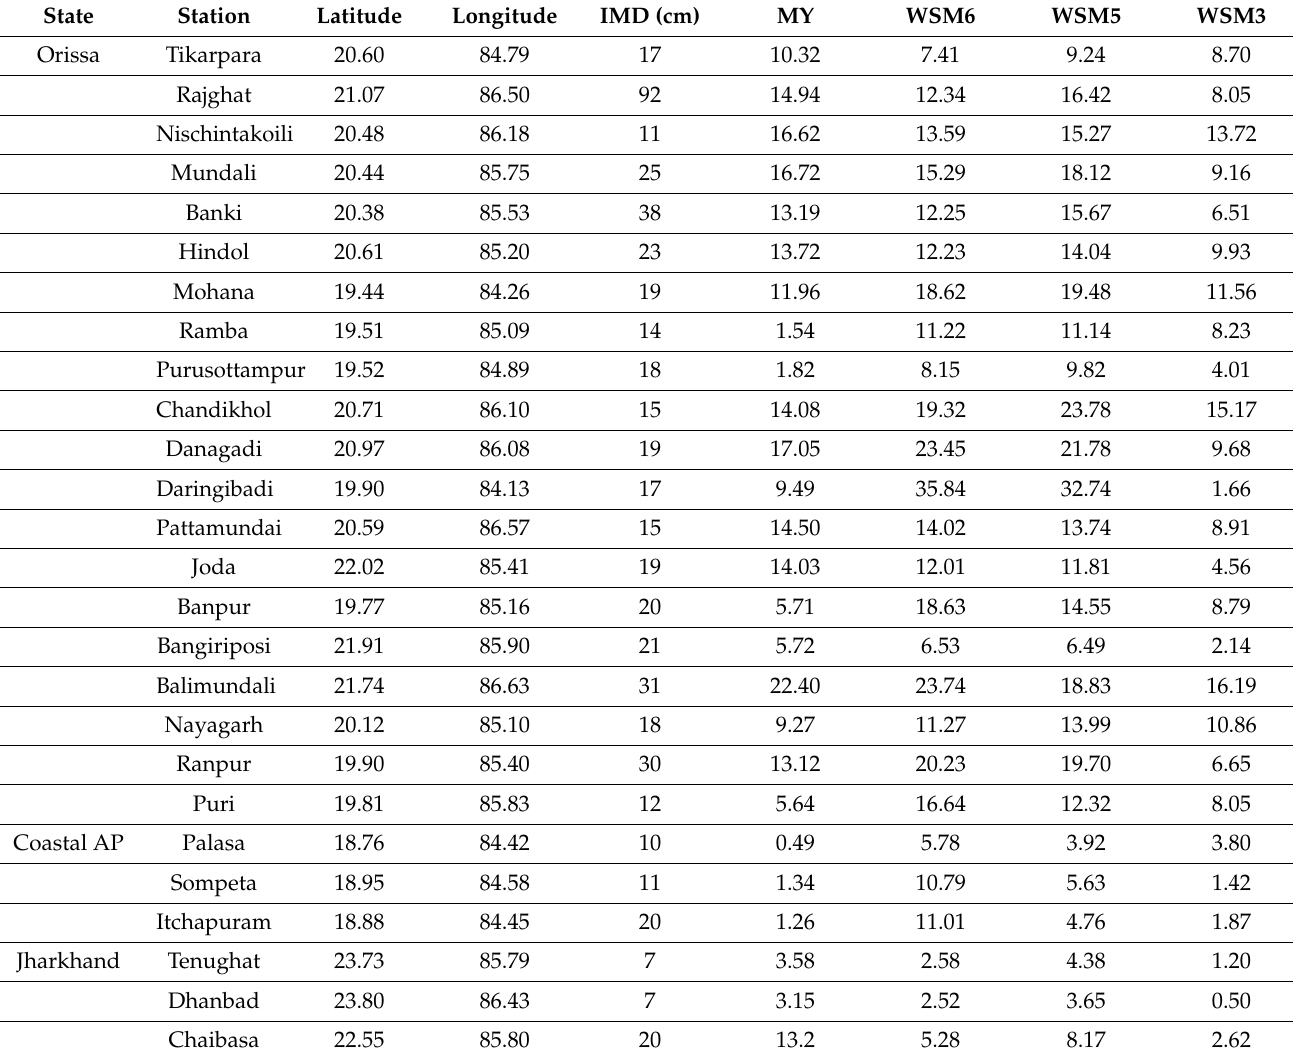
Table 5. Accumulated rainfall (cm) derived from IMD and WRF models (8.333 km) at D02 resolution at different stations over Odisha, coastal Andhra Pradesh, and Jharkhand, valid at 03 UTC, 12 October